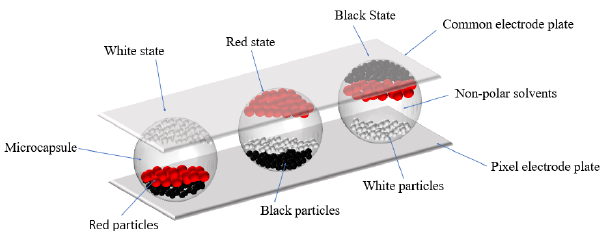
Figure 1. The structure of three three-color EPD pixels. When a negative voltage is applied to the pixel electrode plate, the white particles are driven to the common electrode plate and the pixel displays white, as shown on the left in this figure. When a low-amplitude positive voltage is applied to the pixel electrode plate, the red particles are driven to the common electrode plate and the pixel displays red, as shown on the middle in this figure. When a high-amplitude positive voltage is applied to the pixel electrode plate, the black particles are driven to the common electrode plate and the pixel displays black, as shown on the right in this